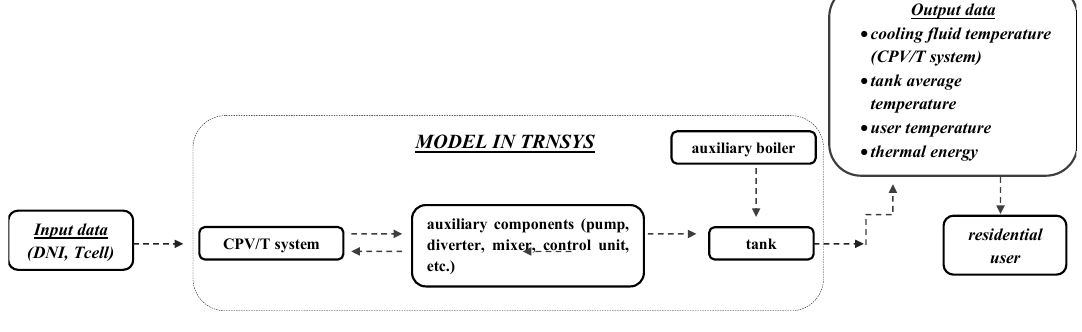
Figure 3. Integrated model of the CPV/T system.